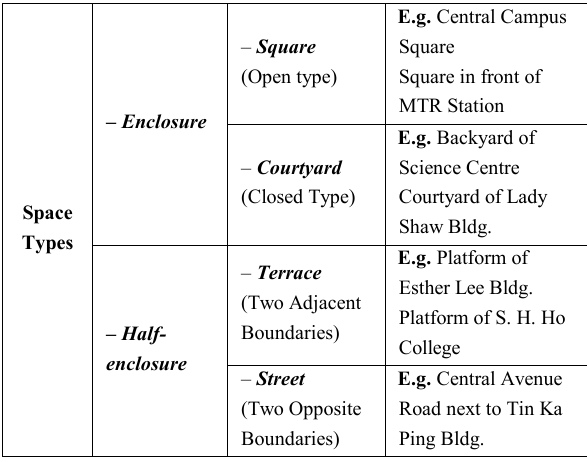
Table 1. Classifications of Space Types in this